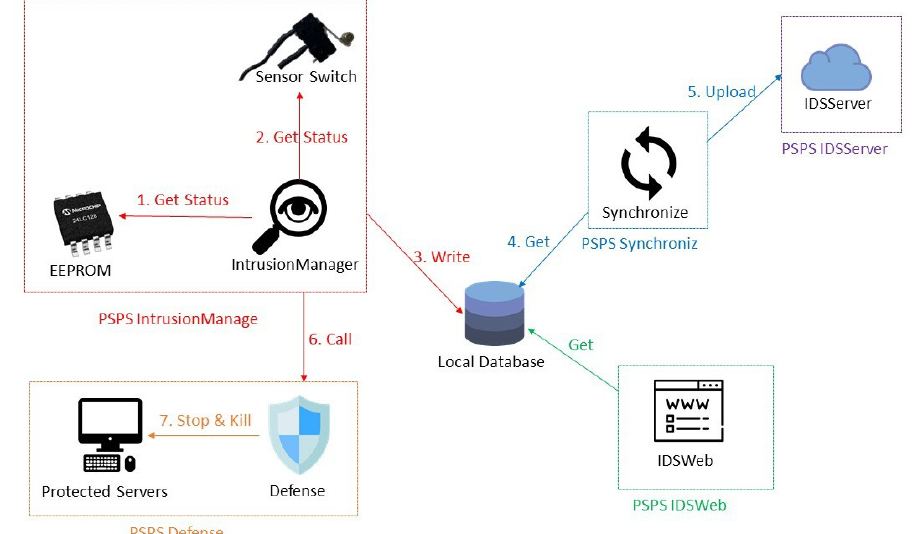
Figure 21. Diagram of the system locking process.